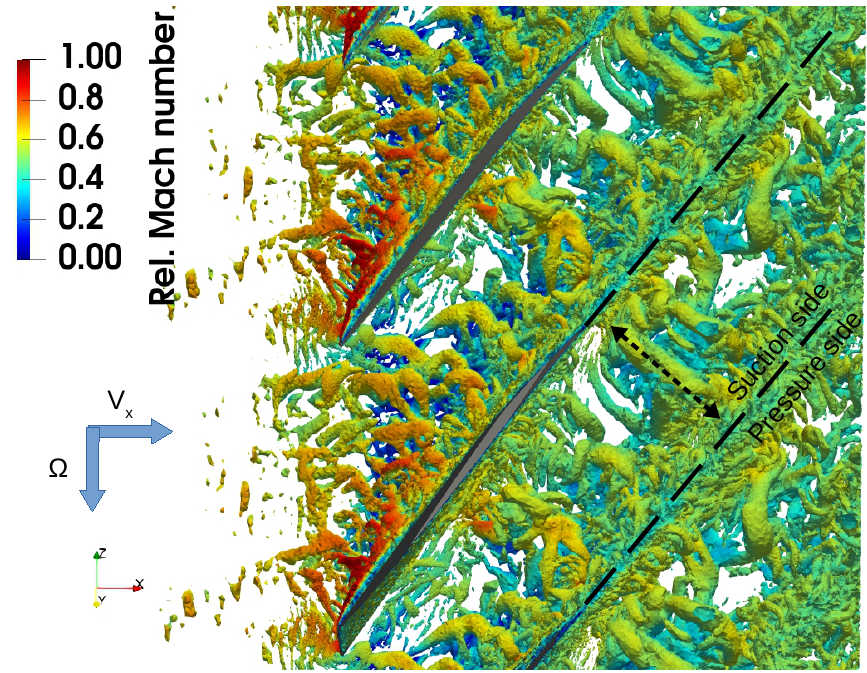
Figure 10. Iso-surfaces of the Q-criterion (3 · 10 − 7 s − 2 ) in the tip region (view from the hub). The black dashed lines indicate the trajectory of the